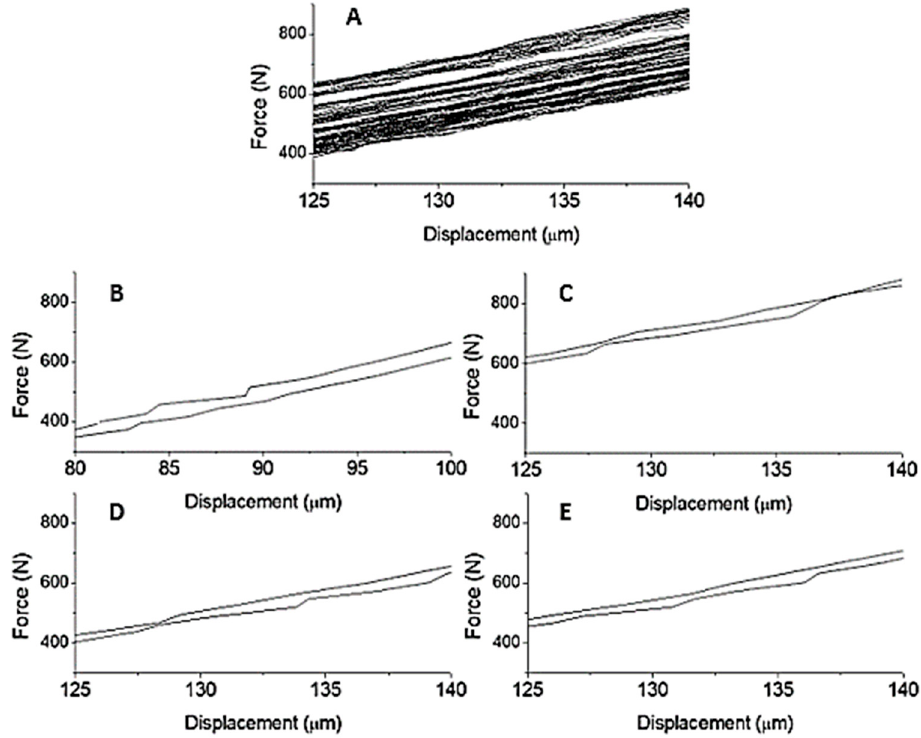
Figure 3. The central section of the hysteresis curves of the bending tensile strength test with cyclic loads of the Solid-B samples: ( A ) all 6000 cycles, ( B ) 1000 cycles, ( C ) 2000 cycles, ( D ) 3000 cycles, and ( E ) 4000 cycles.